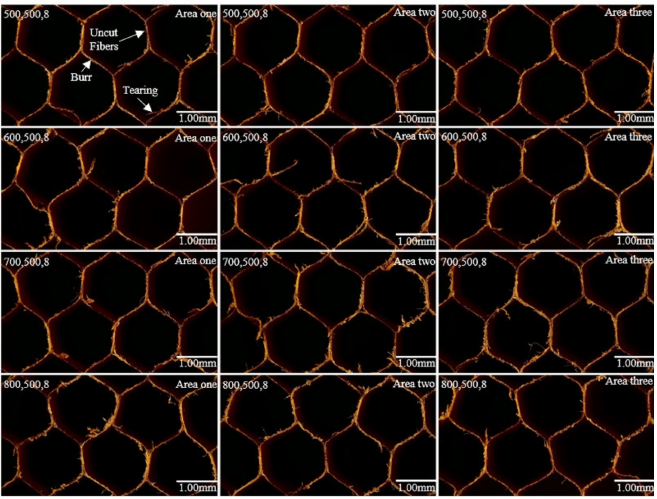
Figure 16. Surface morphology at different spindle speeds.